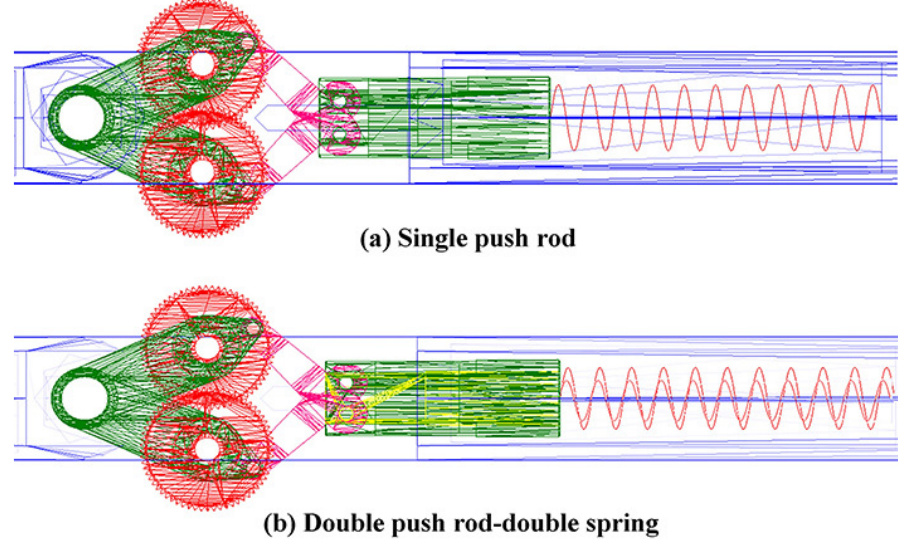
Figure 4. ADAMS simulation models of single push rod support adjustment mechanism, double push rod − double spring support adjustment